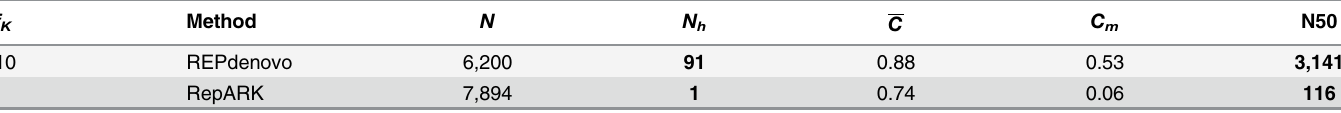
Table 7. Assembly quality comparison of REPdenovo and RepARK. N : the number of assembled contigs. N h : the number of complete Repbase hits from the N repeats (with 85% coverage cutoff). C : average coverage of hits. C m : maximum coverage of hits by single assembled repeats. N50: N50 of assem- bled